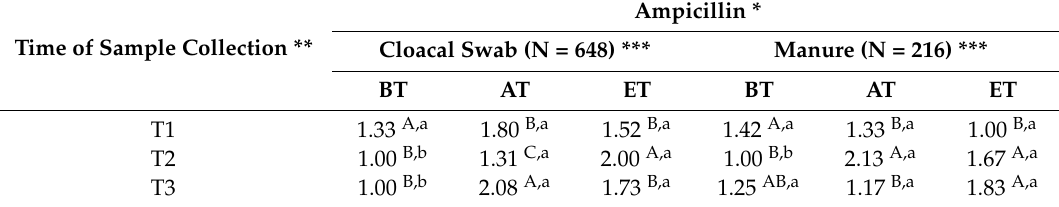
Table 2. Means of ampicillin-resistant E. coli isolates from cloacal swab and litter/excreta samples from